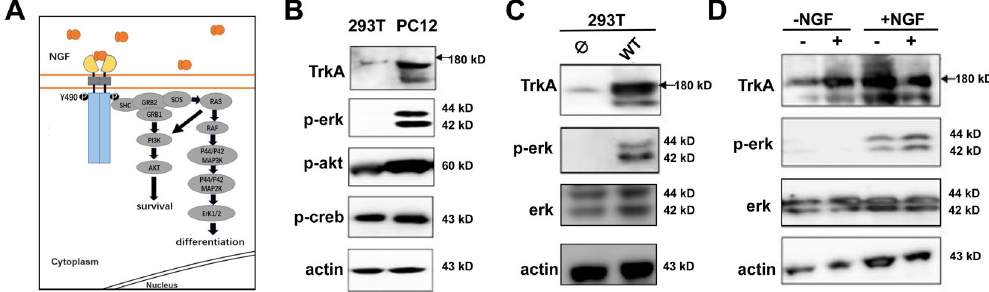
Fig. 2 ERK activation by TrkA. a Schematic diagram of TrkA signaling pathway. b Western blot analysis of PC12 and HEK293T cells due to endogenous TrkA in the presence of ligand NGF for p-erk (phosphorylated ERK at Thr202 and Tyr204), phosphorylated akt, phosphorylated CREB. β -actin was used as loading control. c Western blot analysis of HEK293T cells in non-transfected (Ø) and transfected with wt-TrkA (wt) probing for endogenous TrkA, p-erk and total ERK. β -actin was used as loading control. d Western blot analysis of HEK293T cells expressing wt-TrkA, without ( − ) or with ( + ) NGF, and without ( − ) or with ( + ) UV light, for pERK. β -actin was used as loading control.